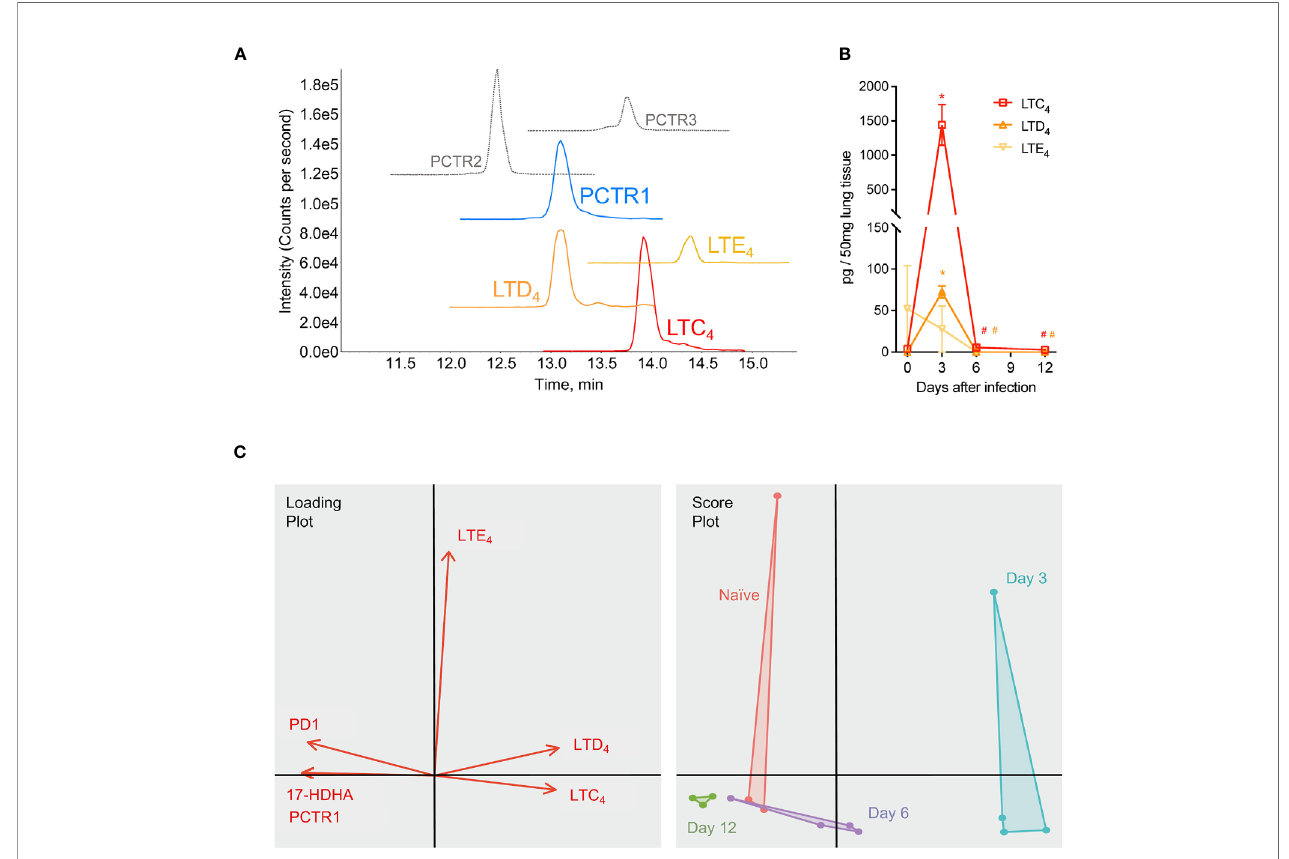
FIGURE 7 | Protectins and cysteinyl-leukotrienes (cys-LTs) are temporally regulated during mouse RSV infection. Mice were infected with 10 5 PFU of RSV and right lung was harvested at the time points stated. (A) Targeted multiple reaction monitoring (MRM) for PCTR1-3, LTC 4 , LTD 4 , and LTE 4 (1.0-point Gaussian smoothed) synthetic material, using Sciex ExionLC and 6500 + Triple Quadrupole QTRAP operated in positive mode (see Table S3 for details). (B) Time course of cys-LTs from RSV infections; data from LC-MS/MS quantitation expressed as pg/50 mg of mouse lung tissue. (C) Principal component analysis plots for PCTR1, PD1, 17-HDHA, LTC 4 , LTD 4 , and LTE 4 in lung tissues of naïve mice (red) or mouse lung tissues at day 3 (blue), day 6 (purple), and day 12 (green) post-infection with RSV. Values are mean of n = 3-4 mice per group ± SEM. * p < 0.01 vs naïve, # p < 0.01 vs day 3 post-infection by one-way ANOVA with Holm-Sidak ’ s multiple comparisons